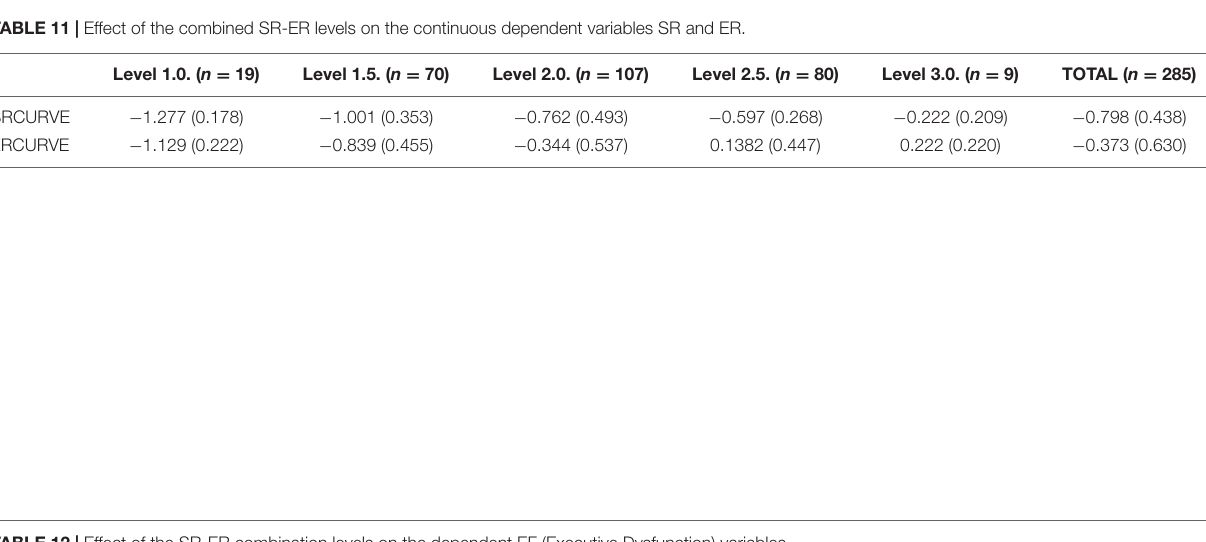
TABLE 12 | Effect of the SR-ER combination levels on the dependent EF (Executive Dysfunction)